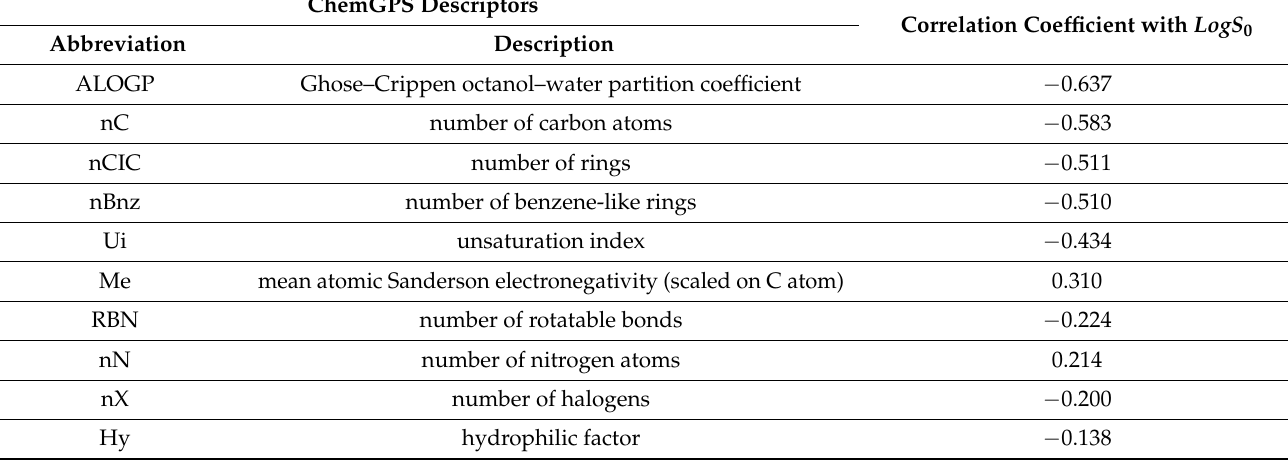
Table 2. List of the 10 selected ChemGPS